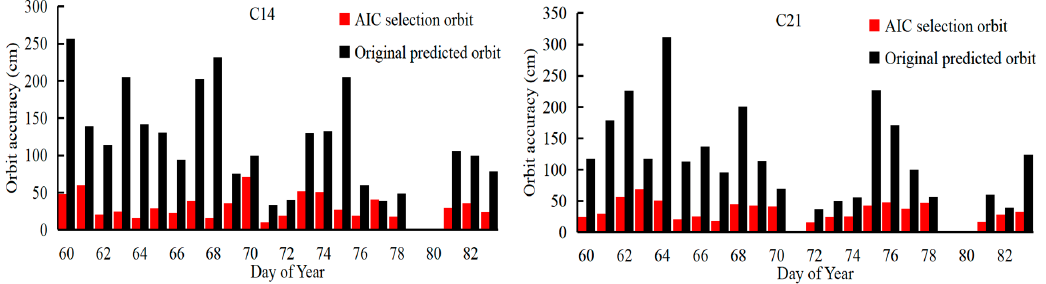
Figure 16. Accuracy of the BDS’s predicted orbit for 21 days from satellites C14 ( left ) and C21 ( right ).